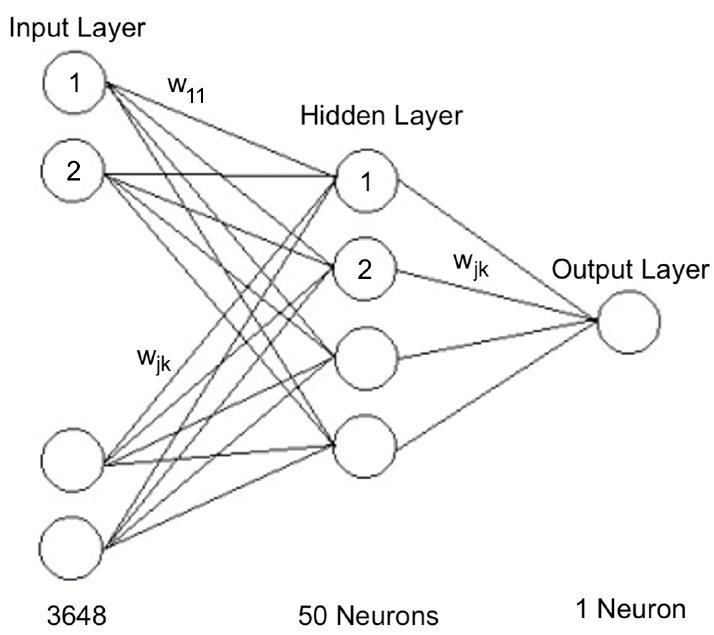
Figure 5. FNN architecture. w jk represent the weight of the